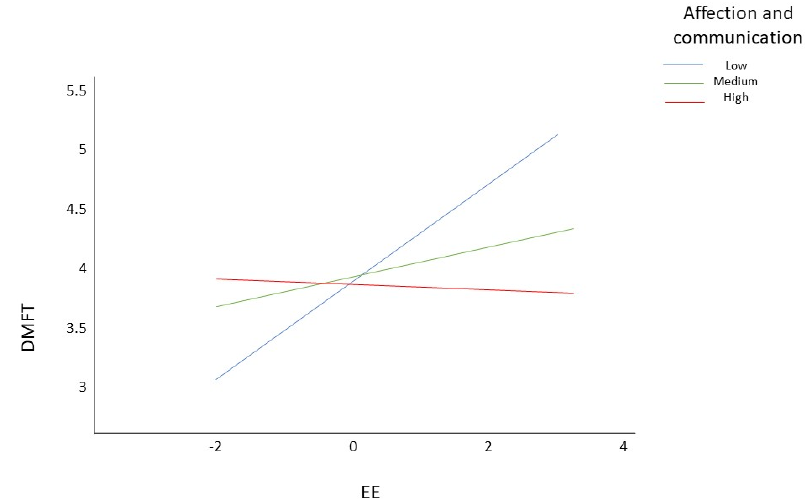
Figure 1. Analysis of moderation of affection and communication on EE and DMFT.